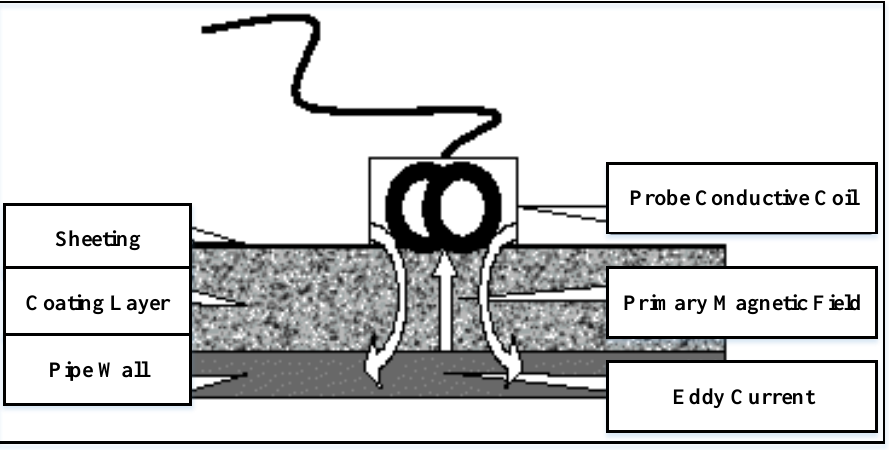
Figure 7. Eddy current framework for corrosion detection and monitoring